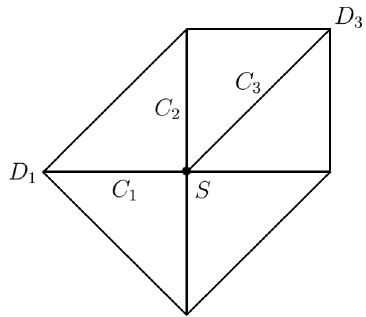
Figure 24 . The toric diagram for dP 2